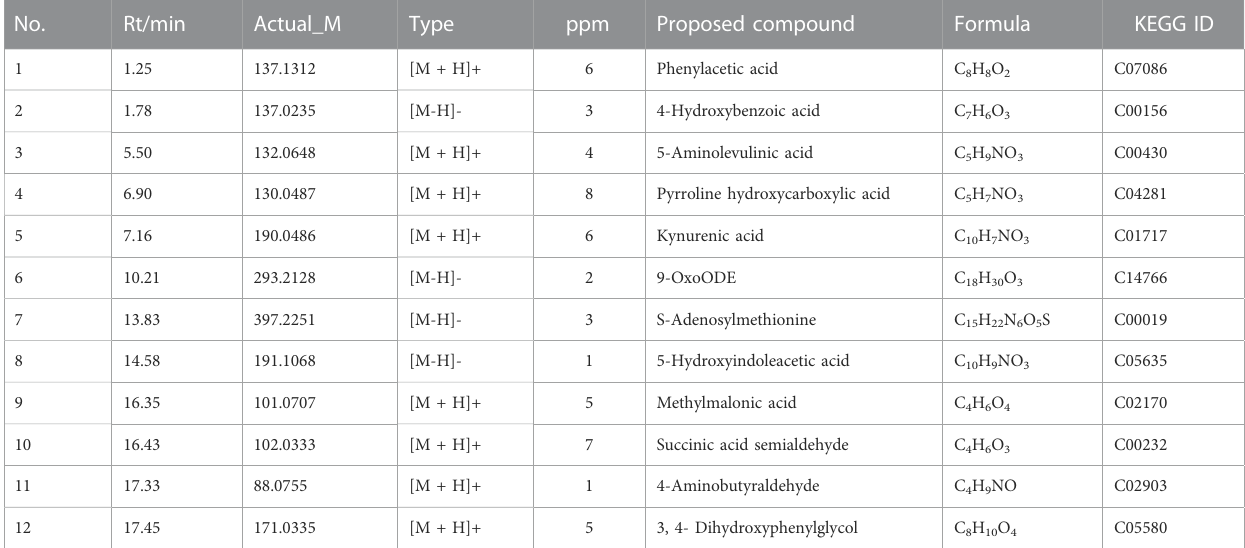
TABLE 4 List of the identi fi cation of potential bio-markers among groups. No. Rt/min Actual_M Type ppm Proposed compound Formula KEGG